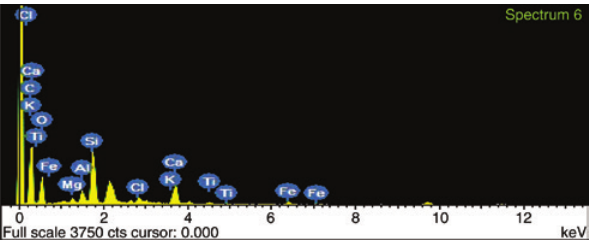
Figure 19: EDAX report of GFRP composites with 5%